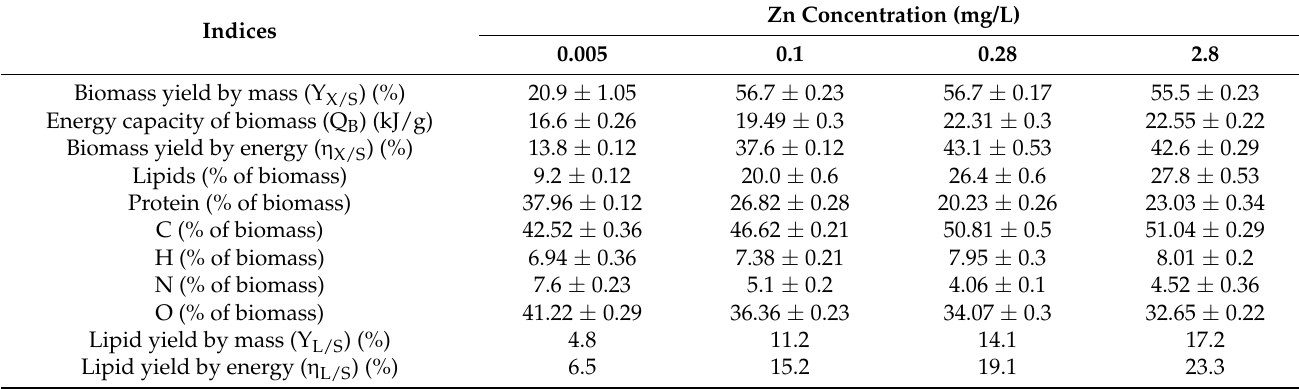
Table 1. Indices of growth and composition of T. globosa VKPM Y-953 biomass at different Zn